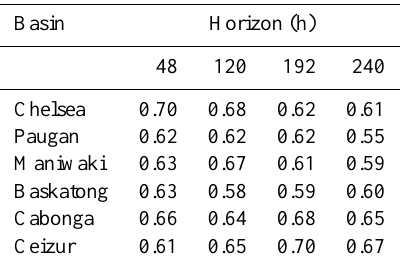
Table 3. Maximum likelihood estimates for SEF model’s weight in predictive distributions formed by a mixture of two gamma